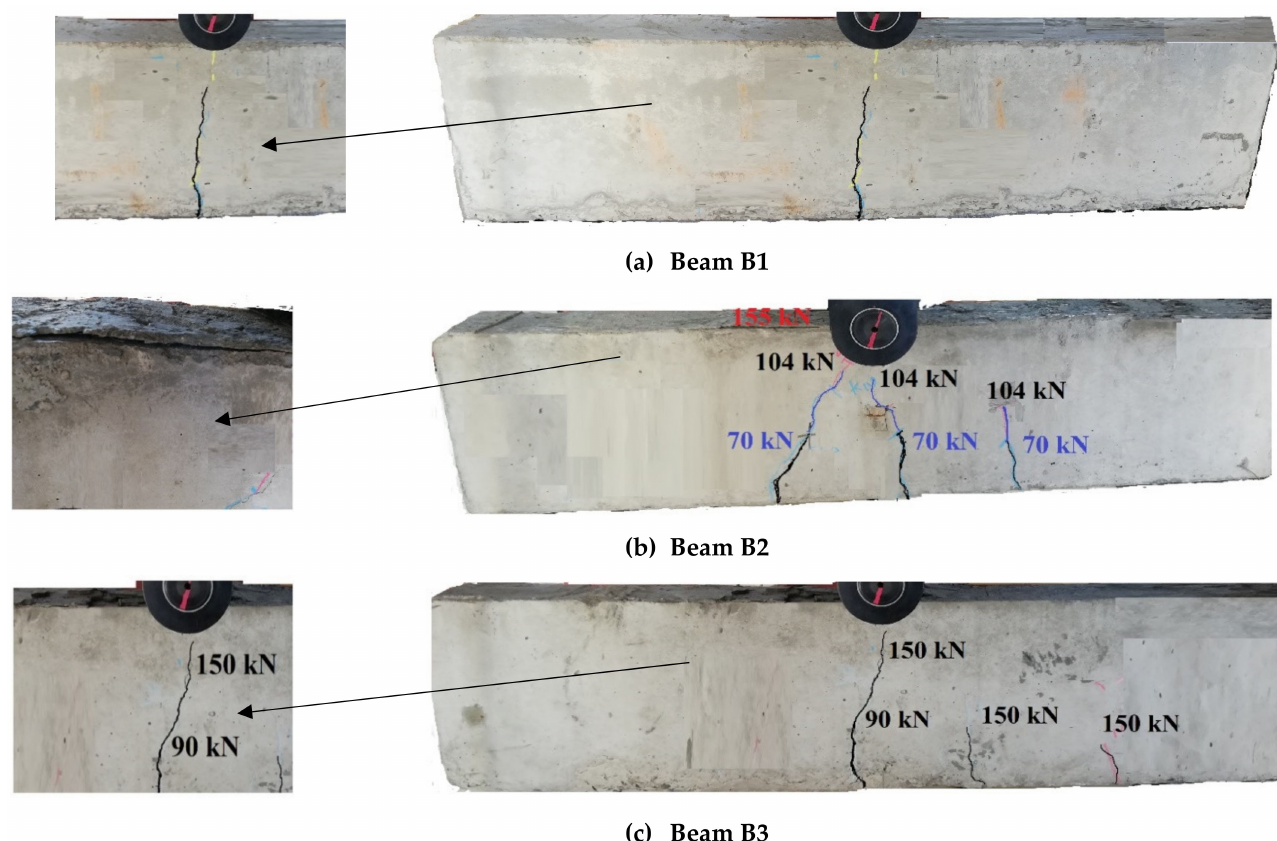
Figure 2. Failure modes of the tested